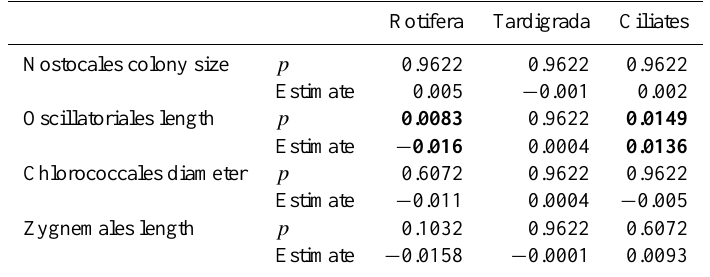
Table 5. Regression table for linear regression models with median and mean sizes of microalgae as dependent variables and grazer densities as explanatory variables. The bold numbers indicate significant correlations.